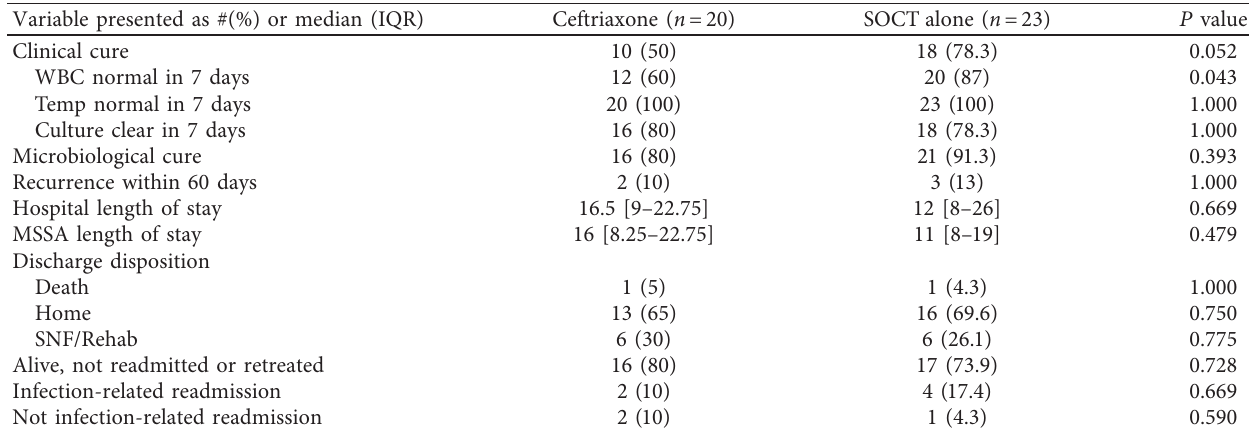
Table 3: Clinical